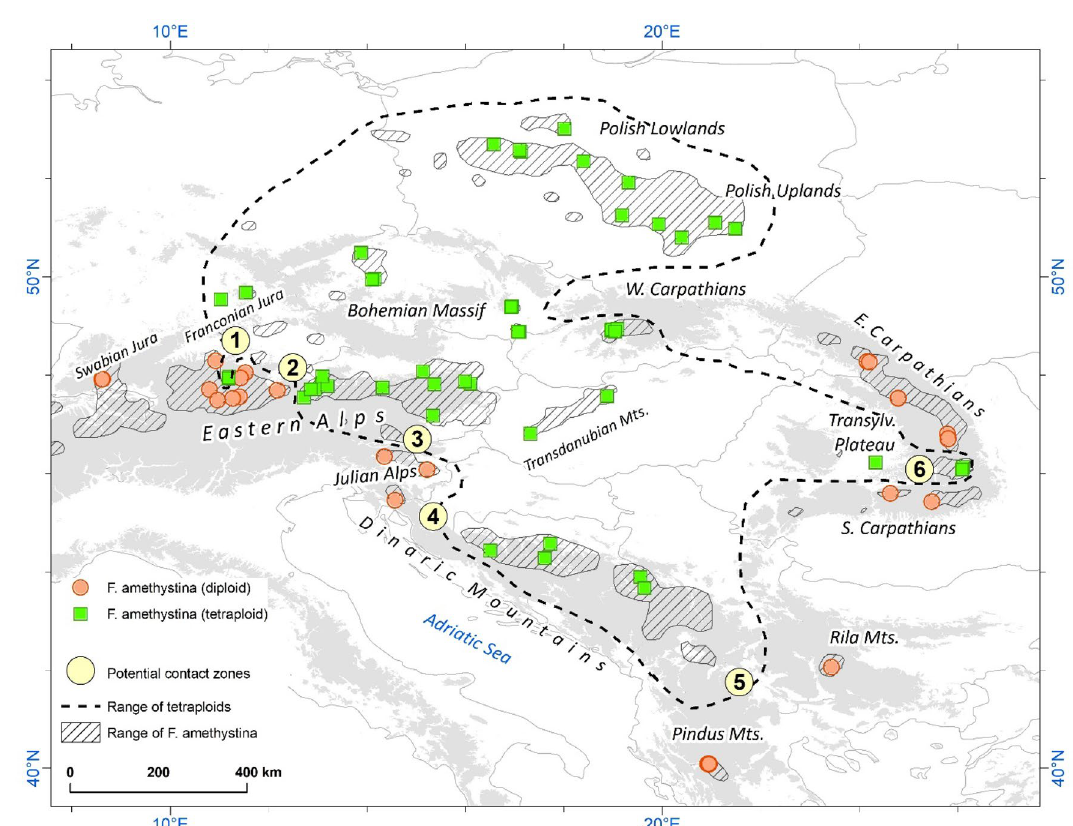
Figure 2. Distribution of diploid and tetraploid cytotypes of F. amethystina . Ploidy level in populations was estimated based on flow cytometry analysis (59 populations) or adapted from literature (11 populations). All populations were found to exhibit homogeneous ploidy. The grey areas indicate an altitude above 500 m. The distribution range of F. amethystina is an updated version of that identified by Kiedrzyński et al. 30 . The numbered potential contact zones between cytotypes are described in Supplementary Table